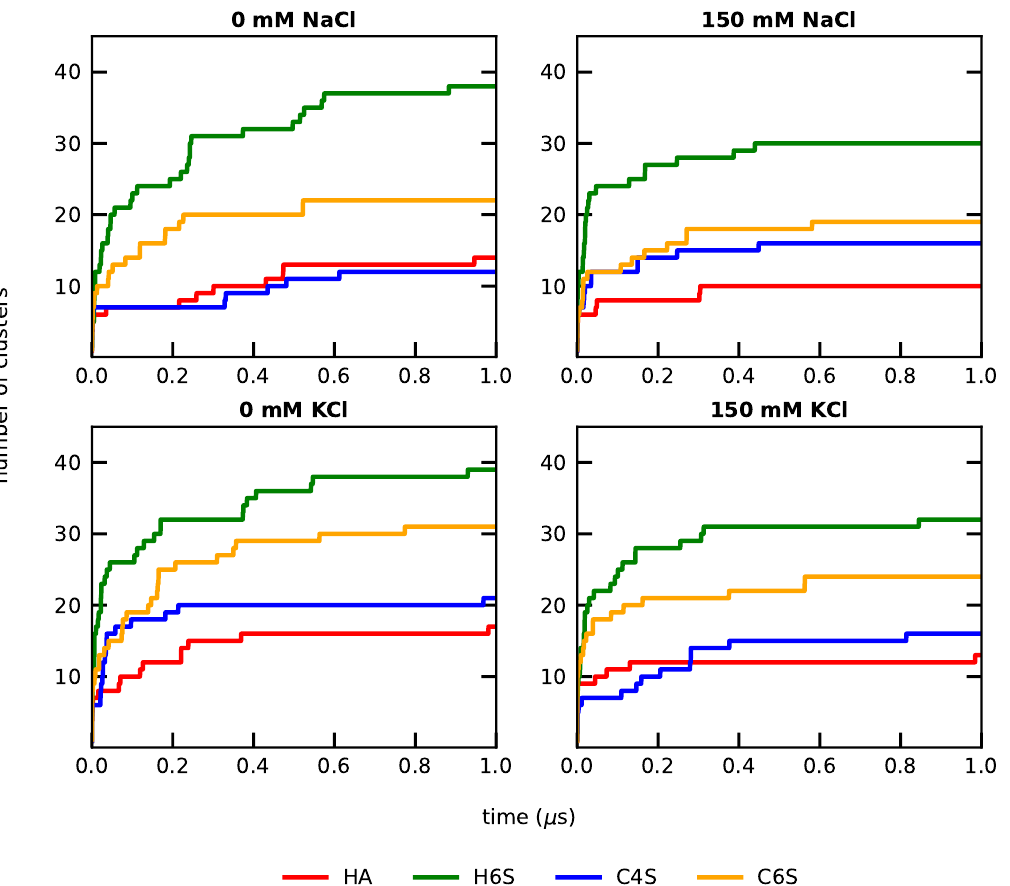
Figure 3. Evolution of the number of conformational clusters at RMSD cutoff = 0.4 nm for the different GAGs (see the color key at the bottom) at the 0 mM ( left ) and 150 mM ( right ) salt concentrations (see the label above each